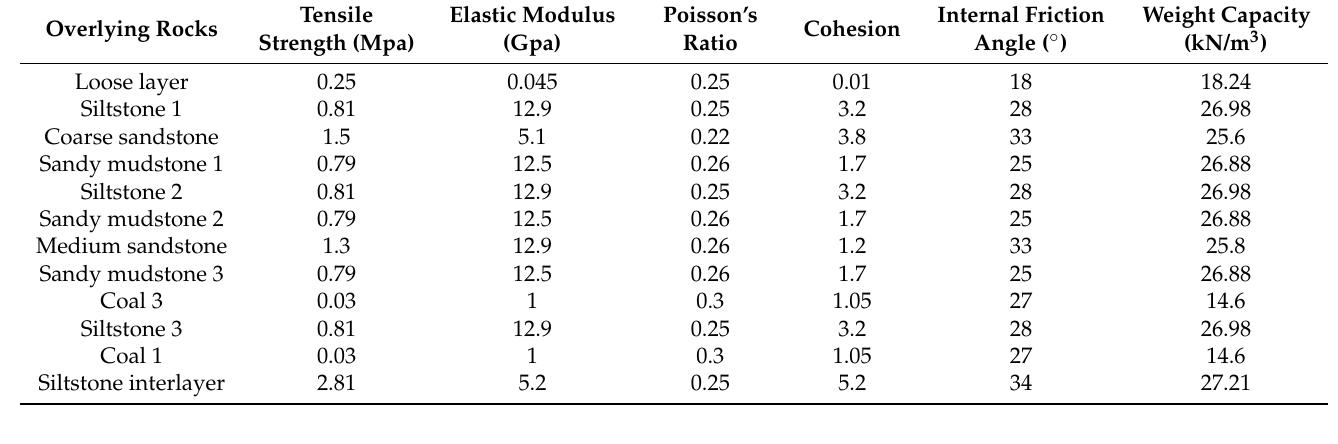
Table 1. Model physical and mechanical parameters.